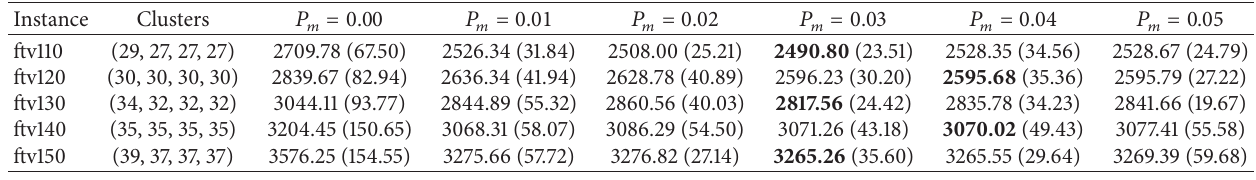
Table 4: Mean and standard deviation of best solution values on five asymmetric TSPLIB instances.